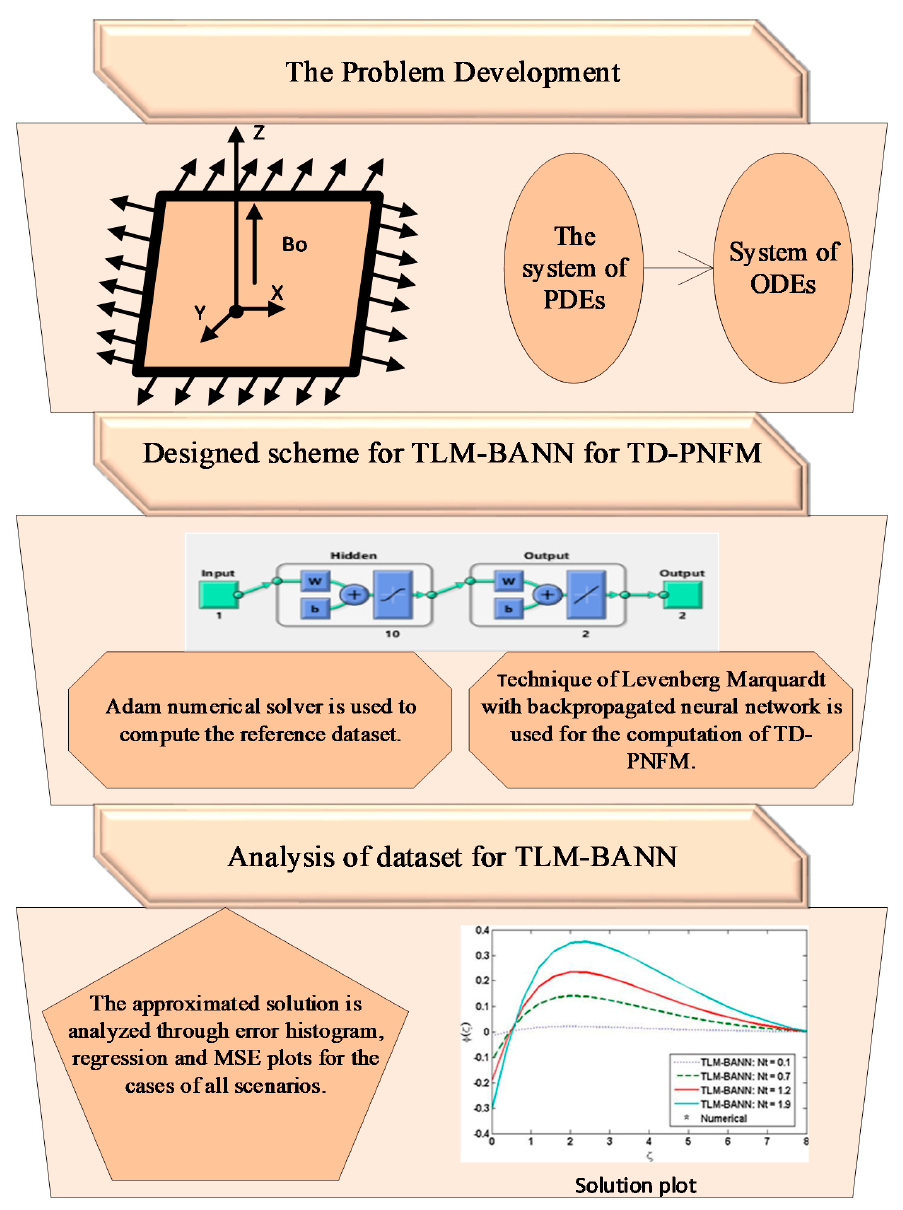
Figure 3. Flow chart for TD-PNFM.